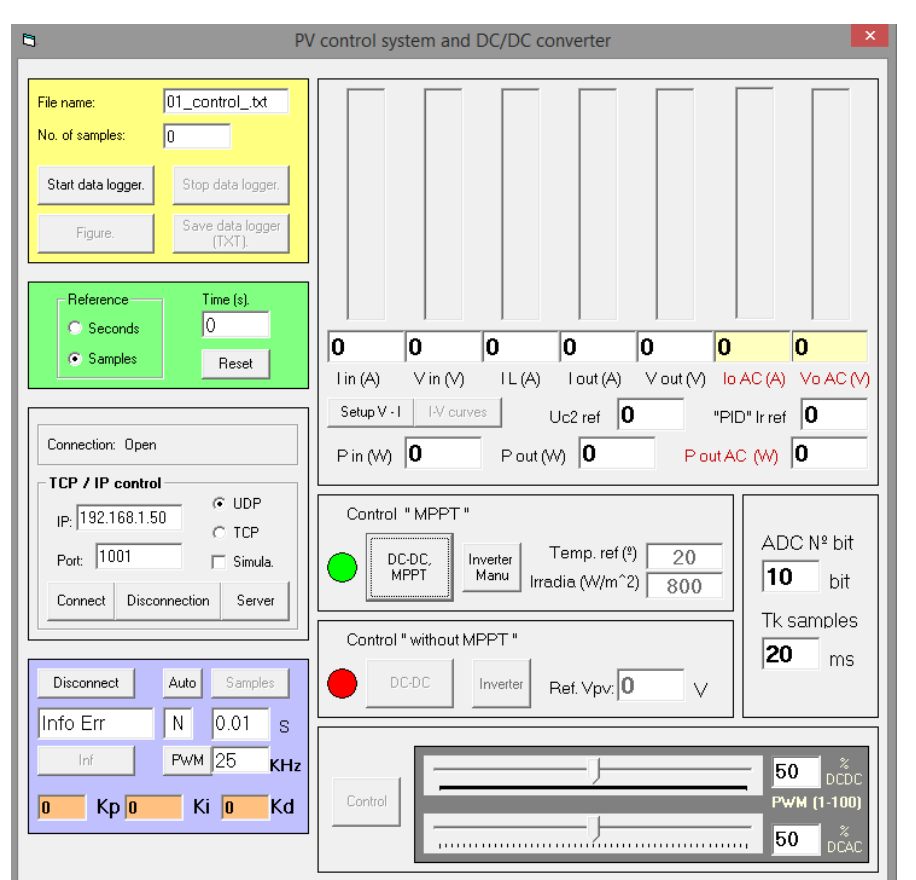
Figure 8. Screen of the designed virtual instrument.